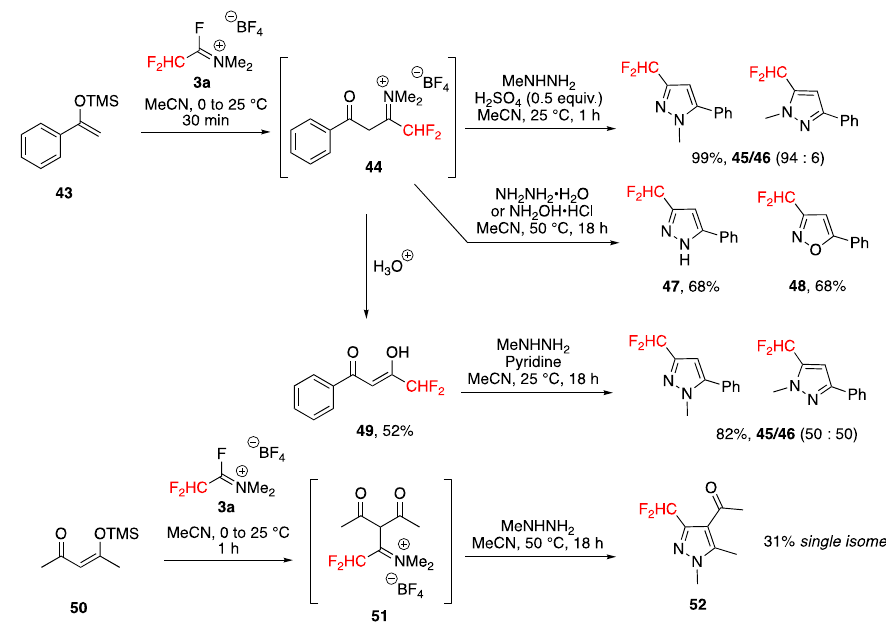
Scheme 15. Reaction of 3a with silyl enol ethers of acetophenone and acetylacetone. Third, 3-difluoromethylpyrazoles and -isoxazoles bearing an amino group in position 5 can